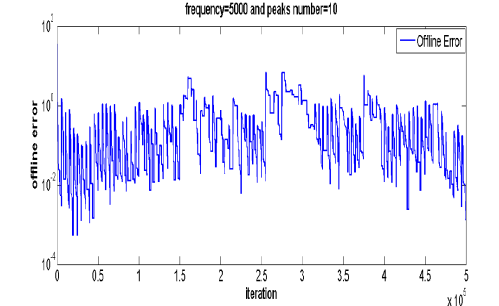
Figure 10. Offline error and current error for proposed algorithm in frequency = 5000 and peak number = 50